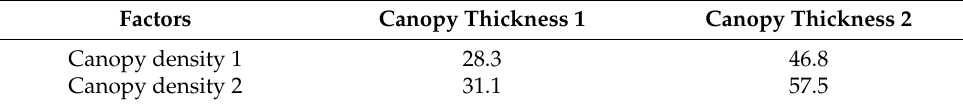
Table 5. Discrimination interaction experiment data 1.